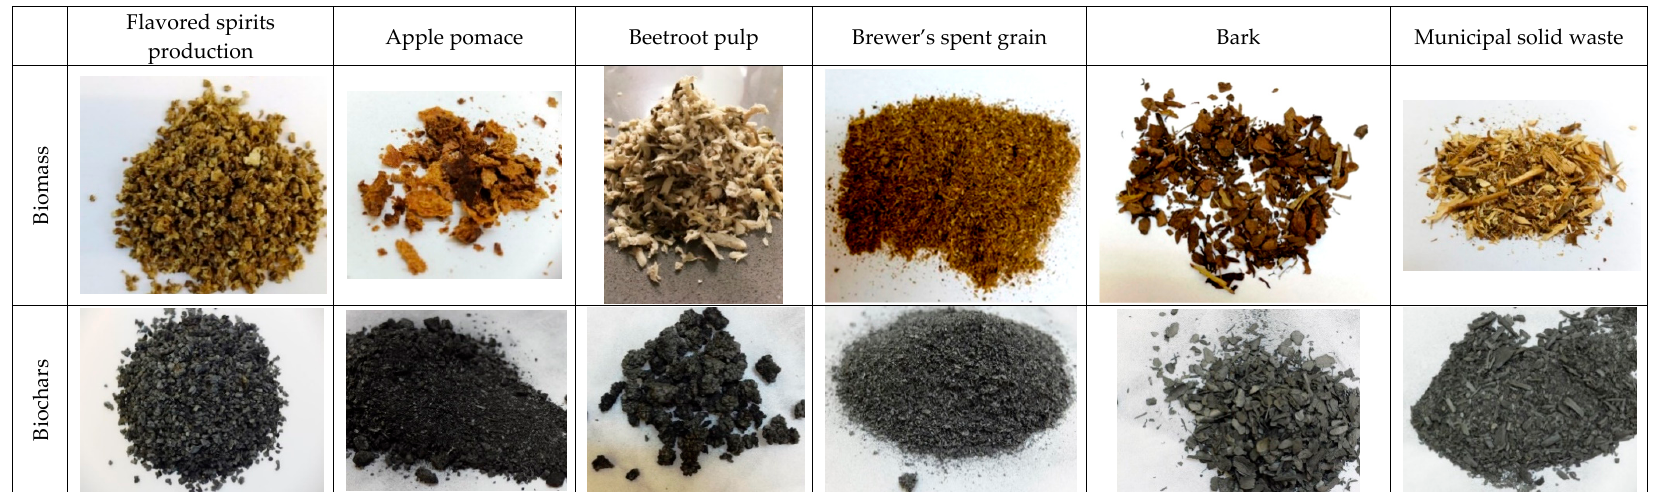
Figure 1. Photographs of the raw and carbonized materials. Thermal decomposition performed under conditions of limited oxygen access with gradually increased temperature up to 850 °C over 30 min and continued for 60 min at a constant temperature.